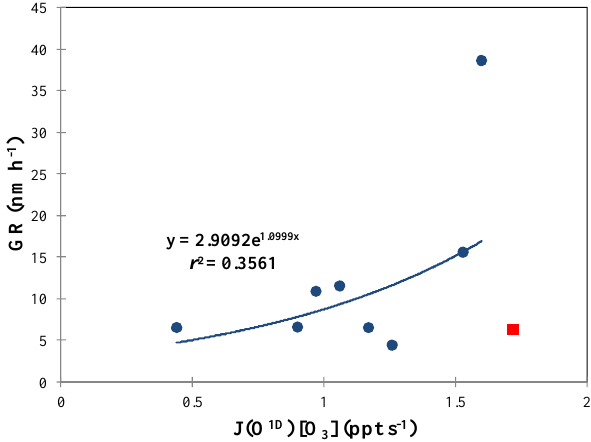
Fig. 9. Correlation between the growth rate of nucleation mode par- ticles and the photolysis of ozone for the NPF events in this study. Photolysis of ozone is assumed to be the dominant term in the pro- duction of OH radicals and, thereby, used as an indicator of photo- chemical production of semi-volatile species that in turn condensed on the preexisting particles and contributed to the particle growth. The square denotes the outlier data point for 11 July 2012 that was excluded from the curve-fitting analysis (see main text for